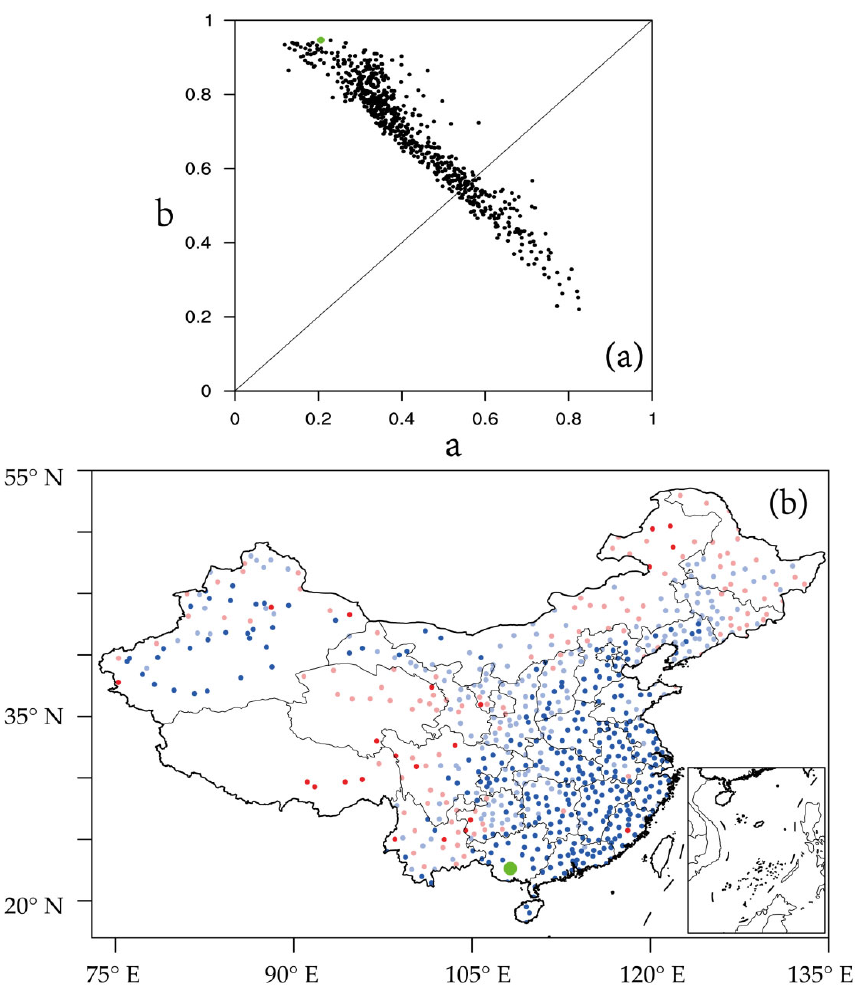
Figure 1. ( a ) Scatter diagram at 27 °C. a is the coefficient of days, b is the coefficient of intensity. ( b ) Spatial distribution map of 27 °C: b > 2a: dark blue; 2a > b > a: light blue; a > 2b: dark red; 2b > a > b: light red.